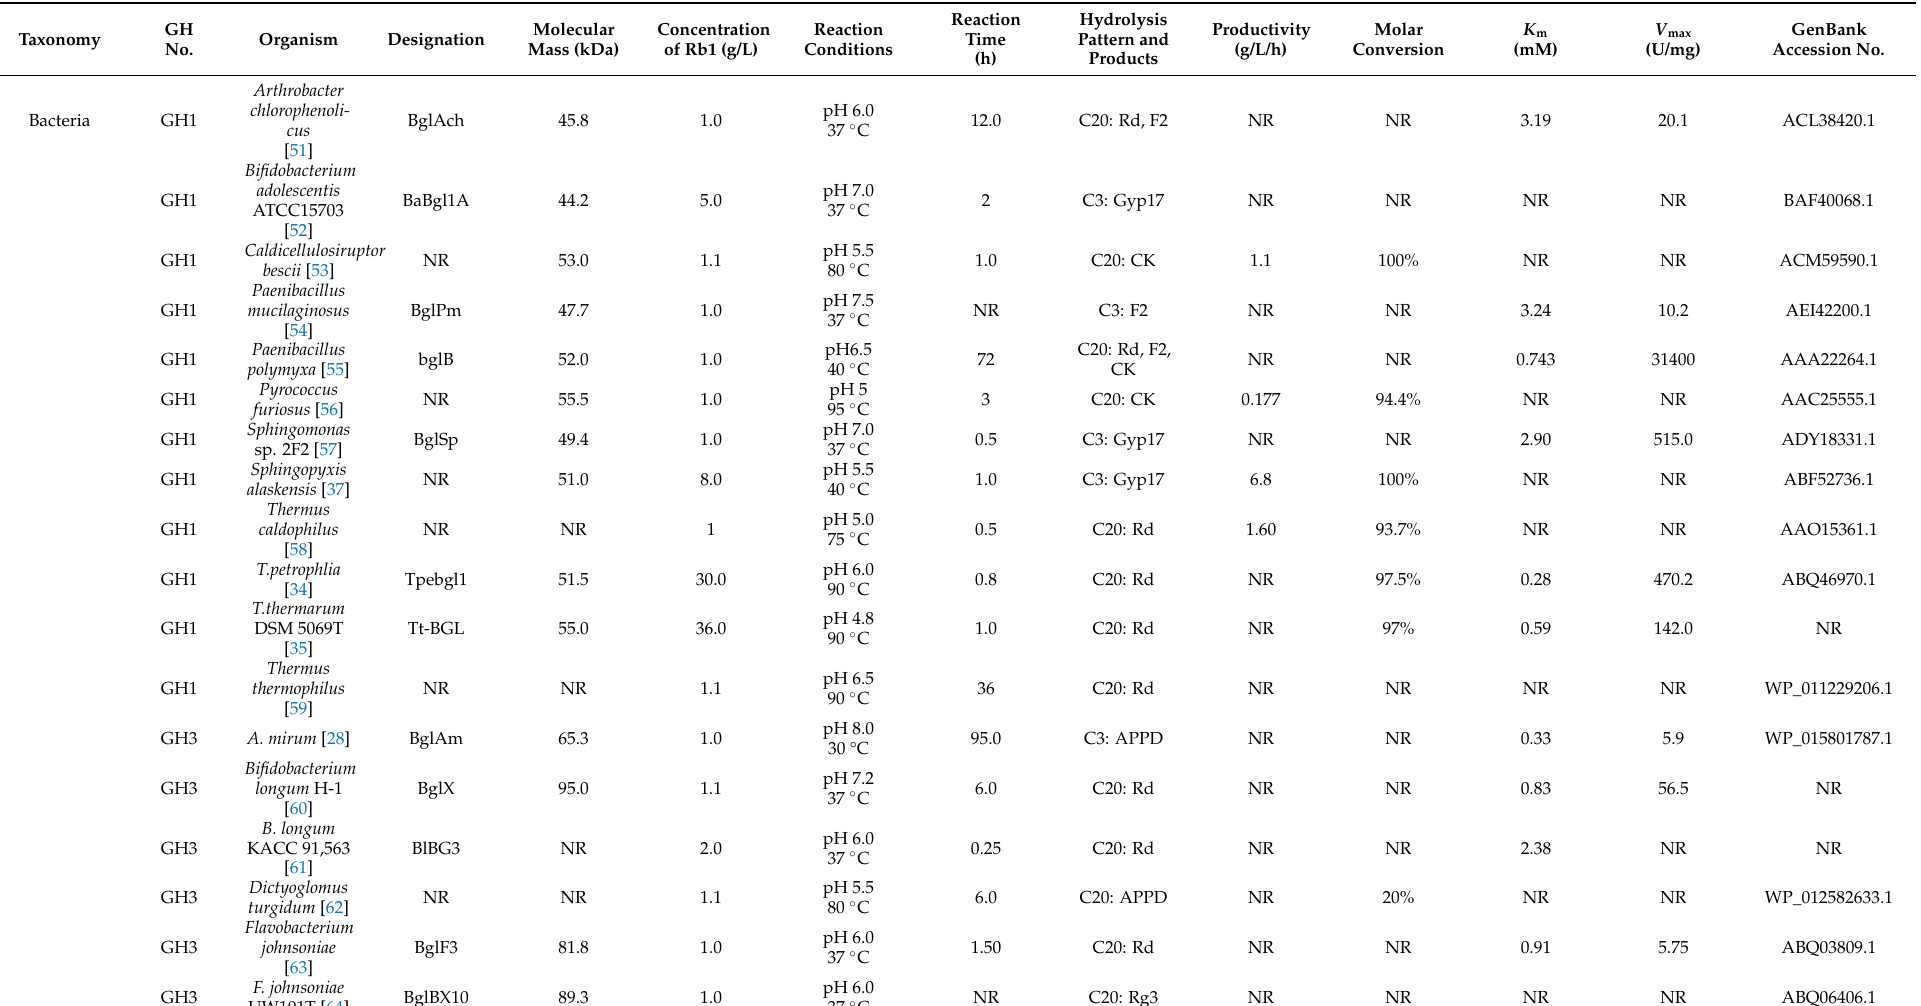
Table 2. β -Glucosidases from different sources for the conversion of ginsenoside Rb1.